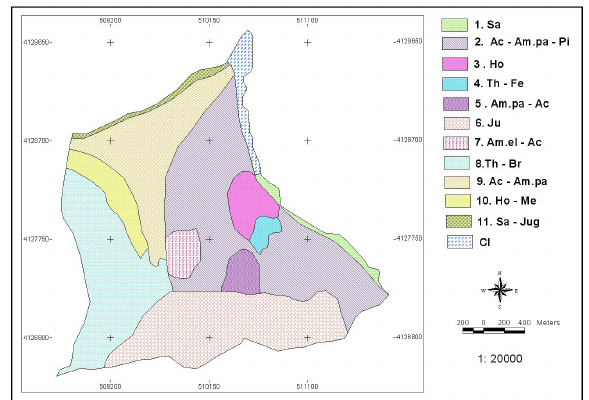
Fig. 1. Coloured vegetation map of study area